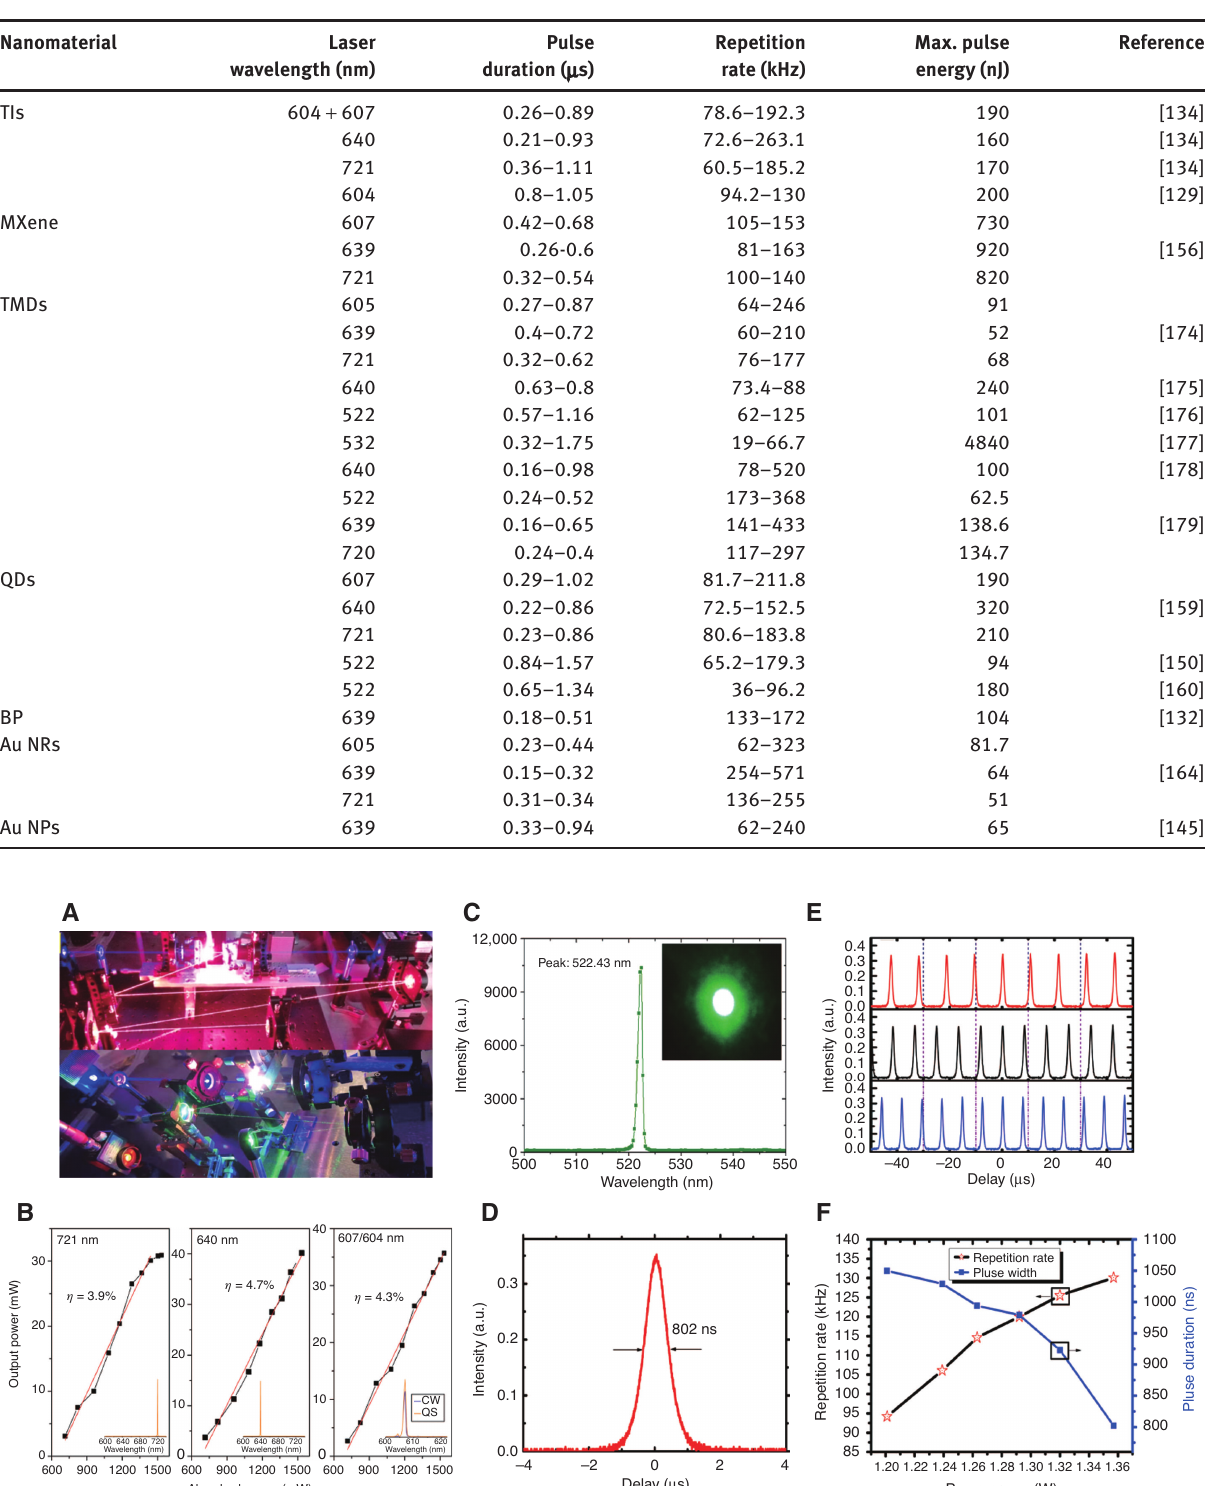
Table 2: Summary of Q-switched solid-state crystal lasers based on nanomaterial SAs.